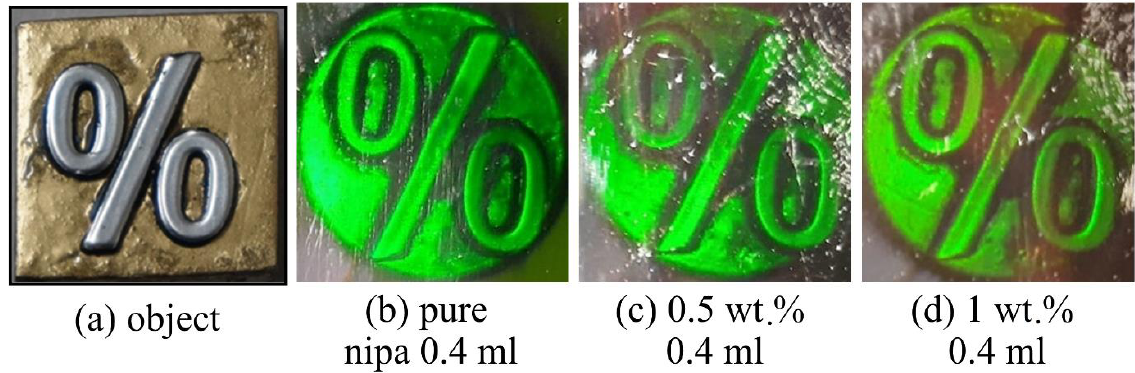
Figure 7. Results of Denisyuk reflection recording in NIPA-based photopolymer and magnetic nanocomposites doped with MNPs Fe 2 O 3 Alpha (average size 20 – 30 nm). ( a ) A photograph of the object, ( b ) hologram recorded in pure NIPA layer (0% wt./wt. concentration of MNPs), ( c ) hologram recorded in magnetic nanocomposite layer having 0.5% wt./wt. concentration of MNPs, ( d ) hologram recorded in magnetic nanocomposite having 1% wt./wt. concentration of MNPs. The layer thickness was about 44 ± 5 µm.